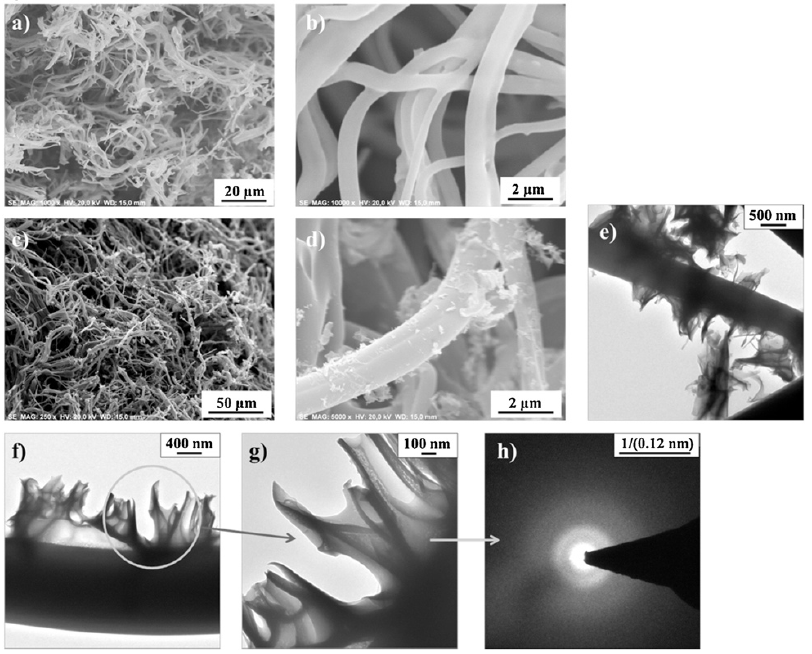
Figure 2. SEM ( a – d ) and TEM ( e – g ) images of carbon ( a , b ) and VPO/CNF ( c – h ) samples. Reproduced with permission from the copyright owner (Elsevier 2016) from Ref. [39].